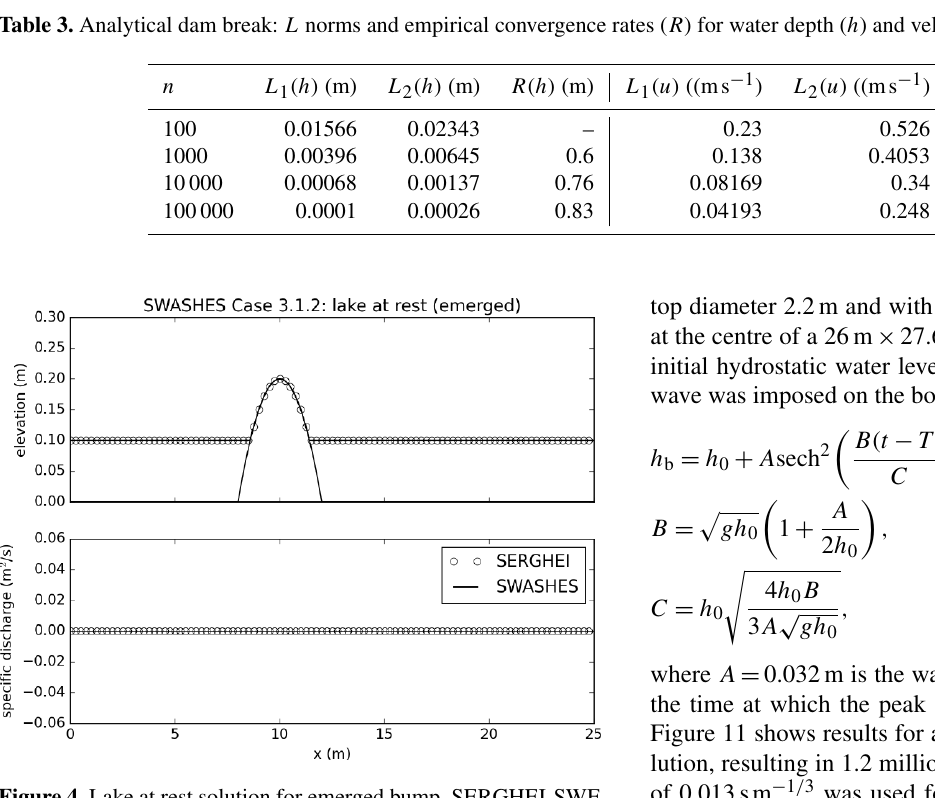
Figure 4. Lake at rest solution for emerged bump. SERGHEI-SWE satisfies the C